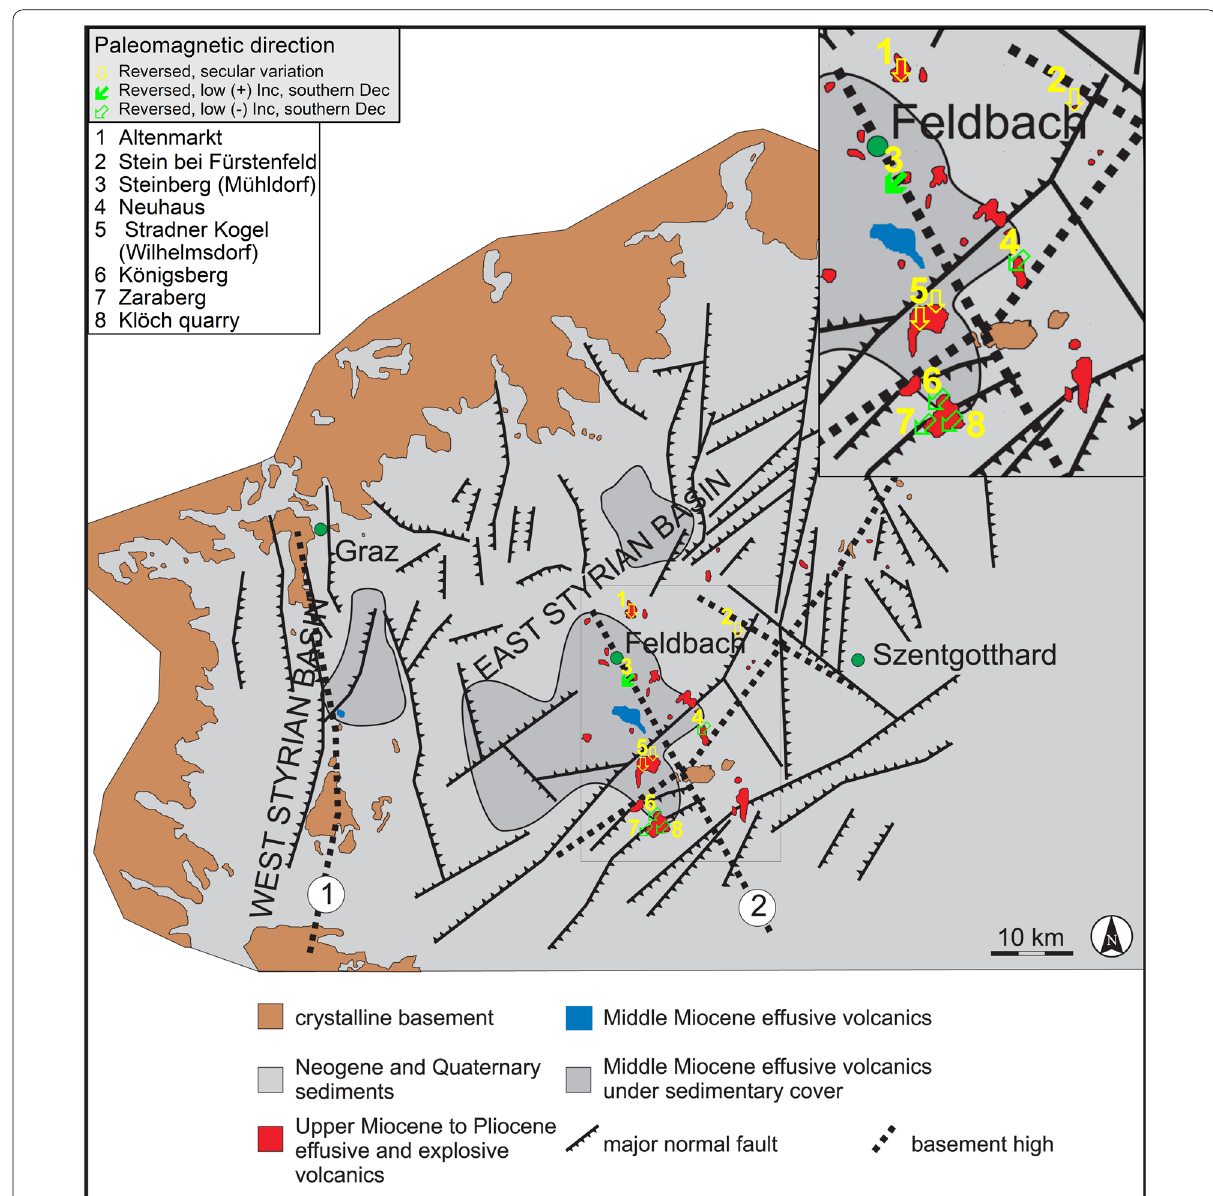
Fig. 11 Map of the Styrian basin showing main geological units, and tectonic and volcanic features ( modified from Bojar et al. 2013). Paleomagnetic sites and results are